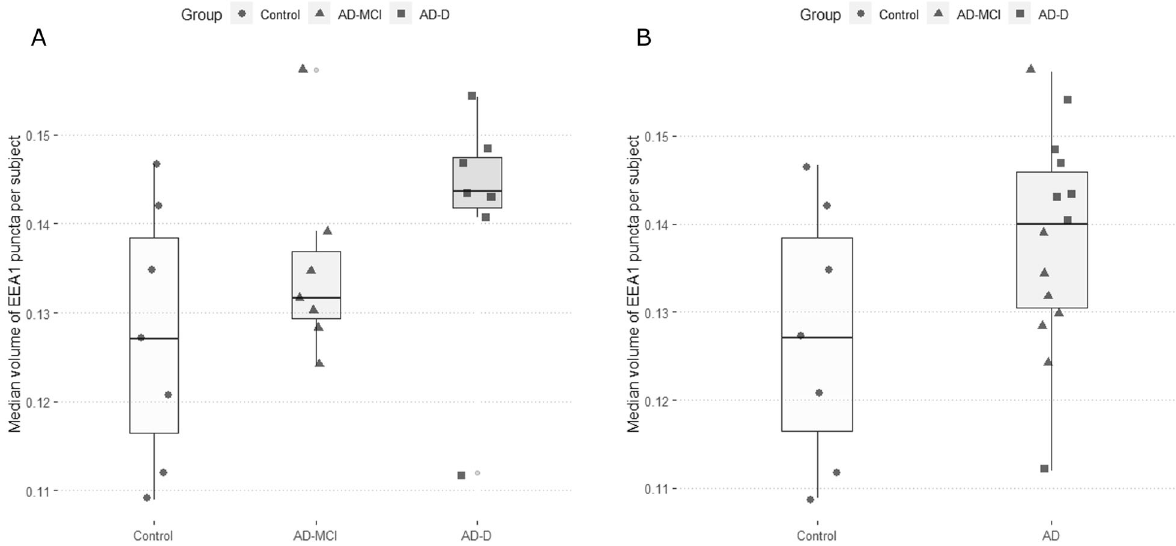
Fig. 1 EEA1 positive puncta volumes in fi broblasts of controls, AD-MCI and AD-D. A Controls are represented as circles and their quartile distribution as a white-colored boxplot, AD-MCI are represented as triangles and AD-D as squares, their respective quartile boxplots are in light and dark grey. B Pooled AD subjects are represented as triangles for AD-MCI and squares for AD-D and their pooled quartile distribution is represented in light grey.